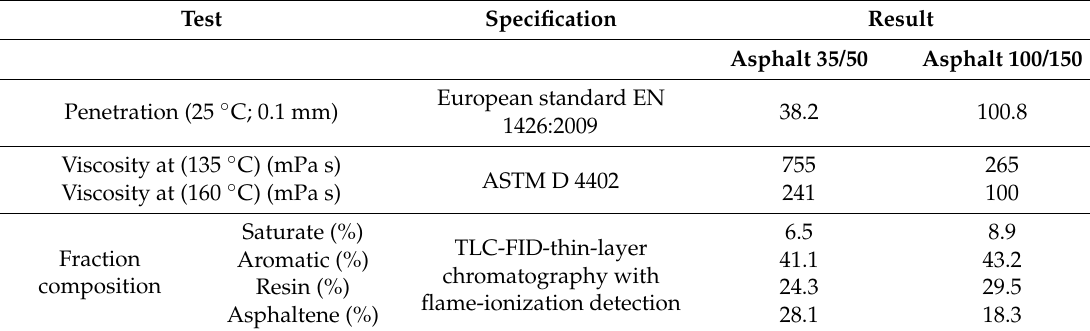
Table 3. Properties of the base